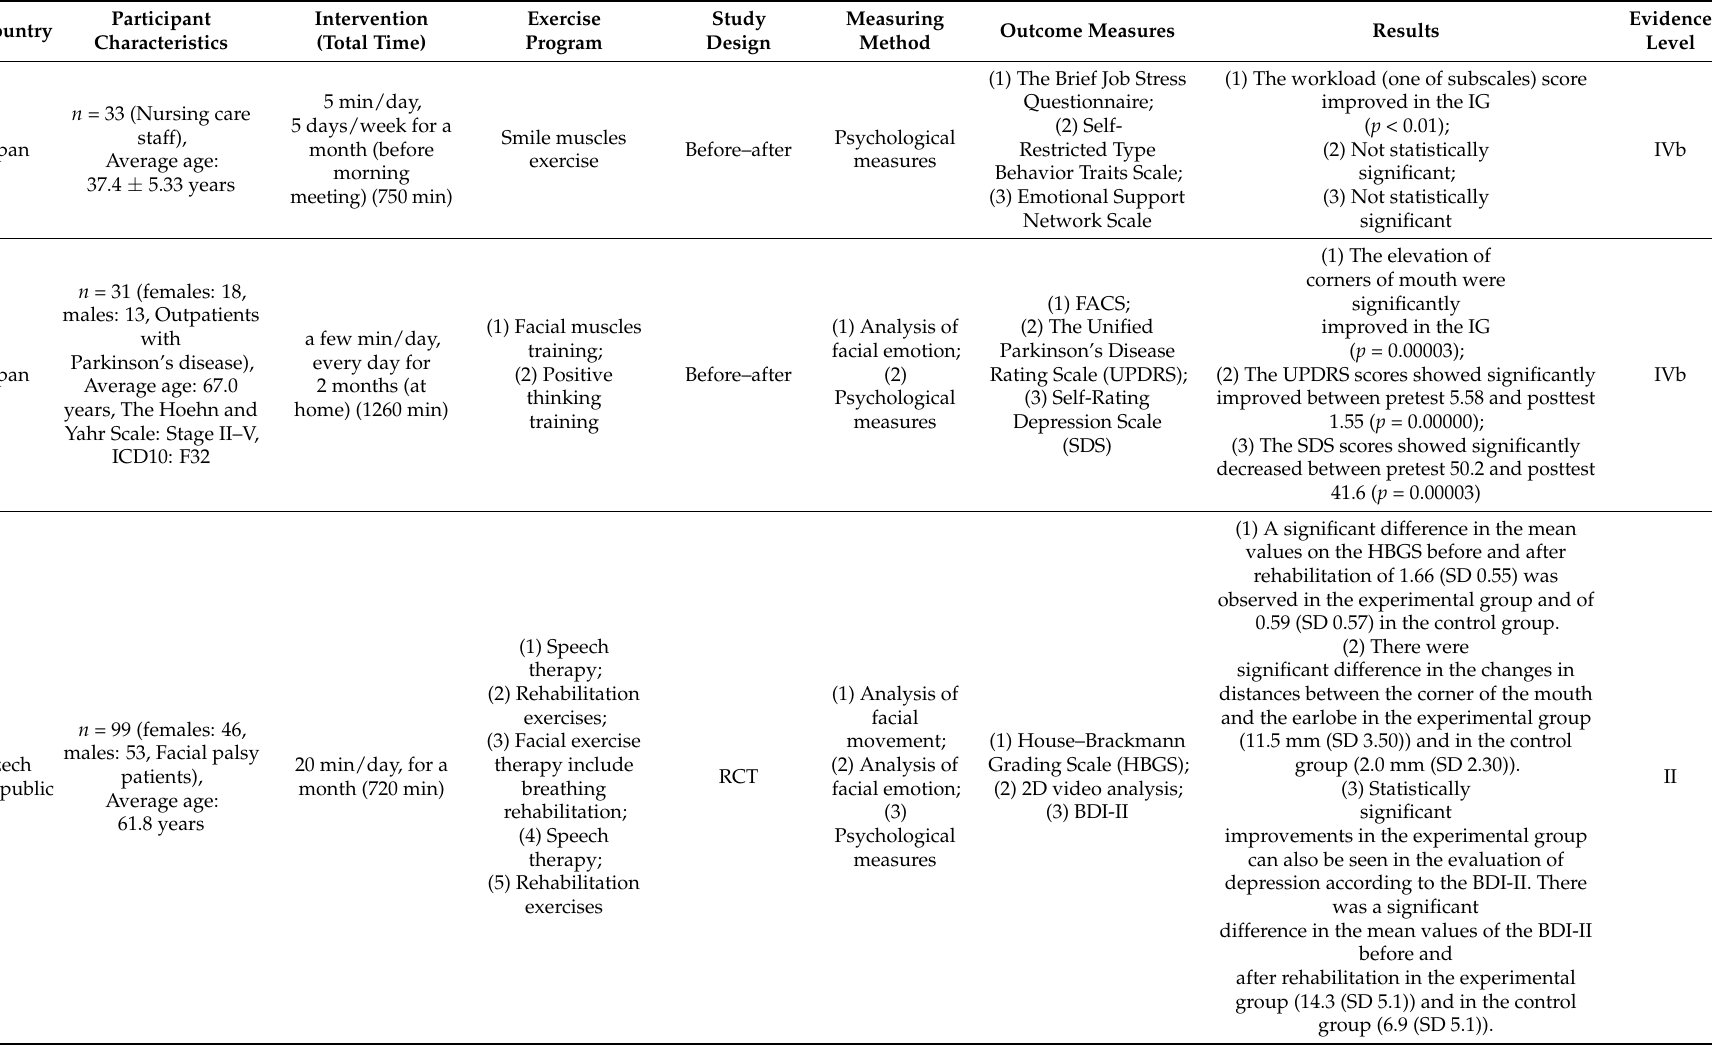
Table 2. Characteristics of included